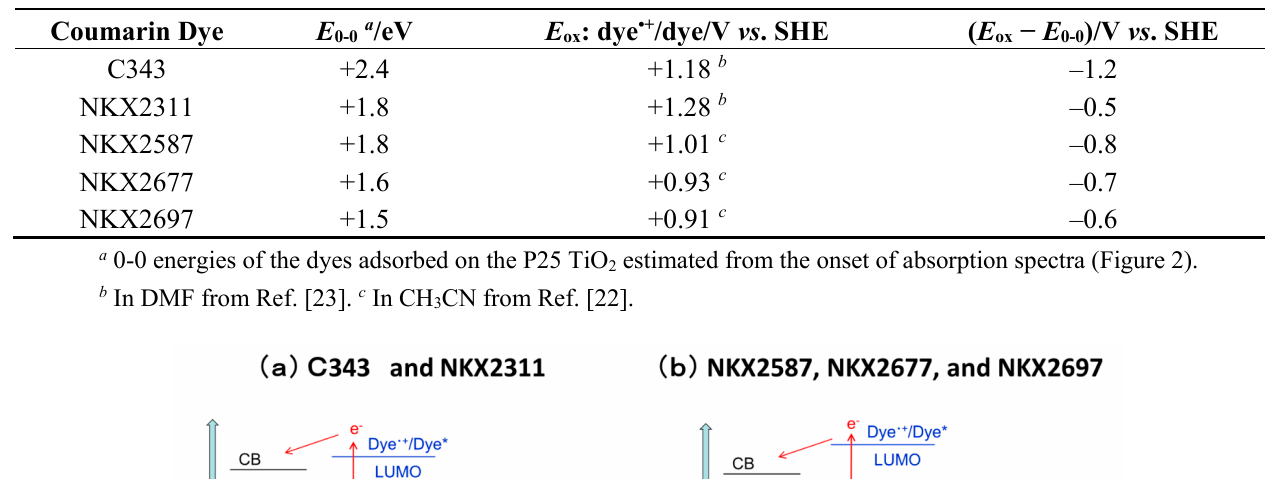
Table 2. Properties of coumarin dyes.